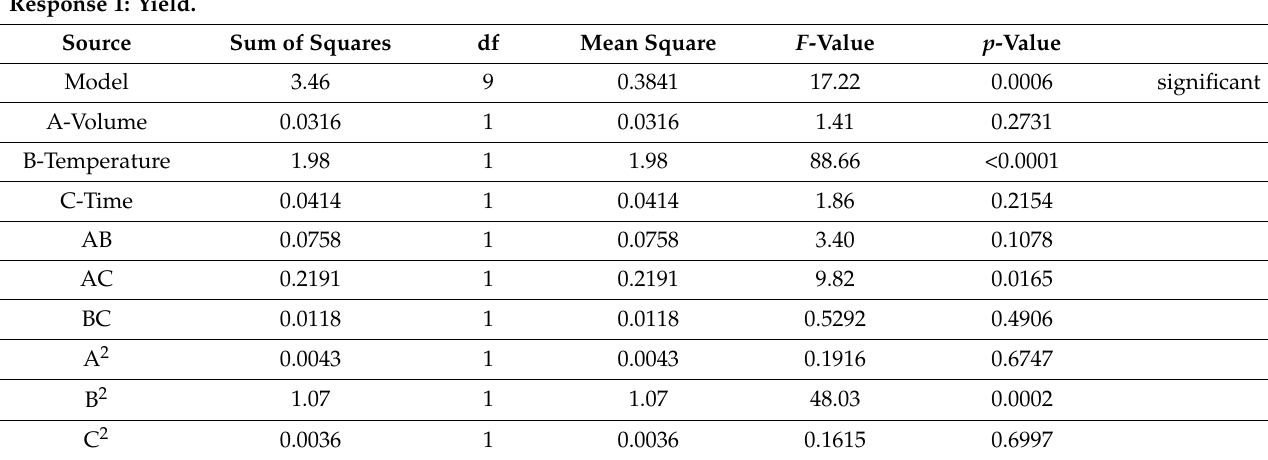
Table 3. ANOVA for quadratic model